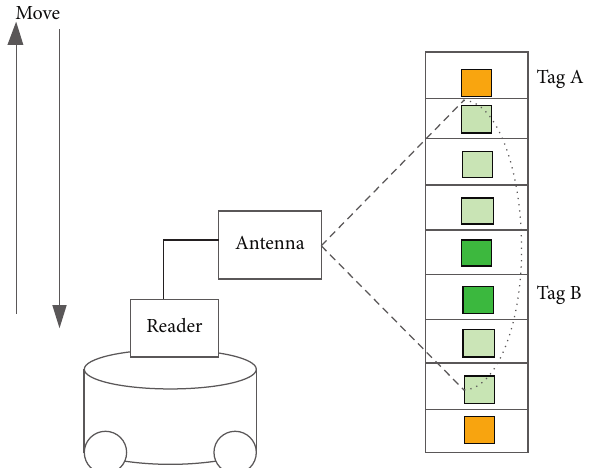
Figure 5: Schematic diagram of the novel mobile RFID system with the robotic vehicle.